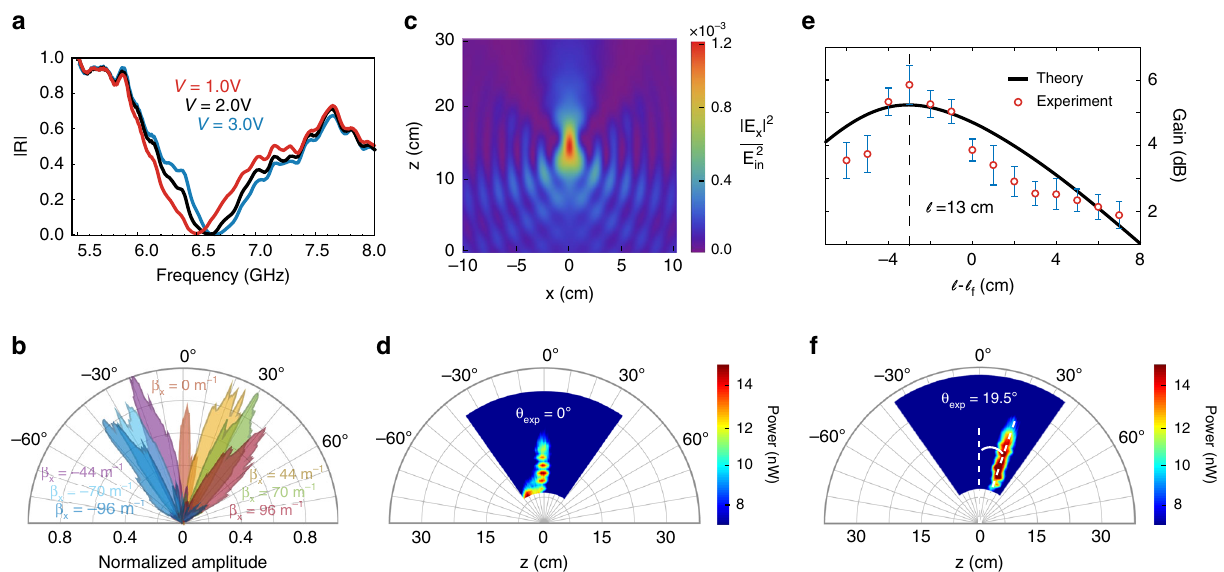
Fig. 2 Dynamical wave-front shaping. a Re fl ectance measurements for the unmodulated metasurface. b Measured on-demand dynamical beam steering of the n = + 1 harmonic. c Calculated spatial distribution of the electric fi eld for on-axis focusing for the n ¼ (cid:2) n ¼ þ 1 frequency harmonic (in fi nite-sized STMM). d Measured power for on-axis focusing. e Calculated ( fi nite-sized STMM, L x = 19 cm) and measured gain as a function of ‘ for off-axis focusing. Error bars are determined by the standard deviation of gain over a narrow angular range within the focal region. f Measured power for off-axis focusing. In b – f , k in = 0, ω in = 2 π × 6.9 GHz and Ω = 2 π × 50 kHz. Input power in the experiments is 6.3 mW. Focusing parameters are ( x f , z f ) = (0,15) cm and (6,15) cm for on-axis and off-axis,